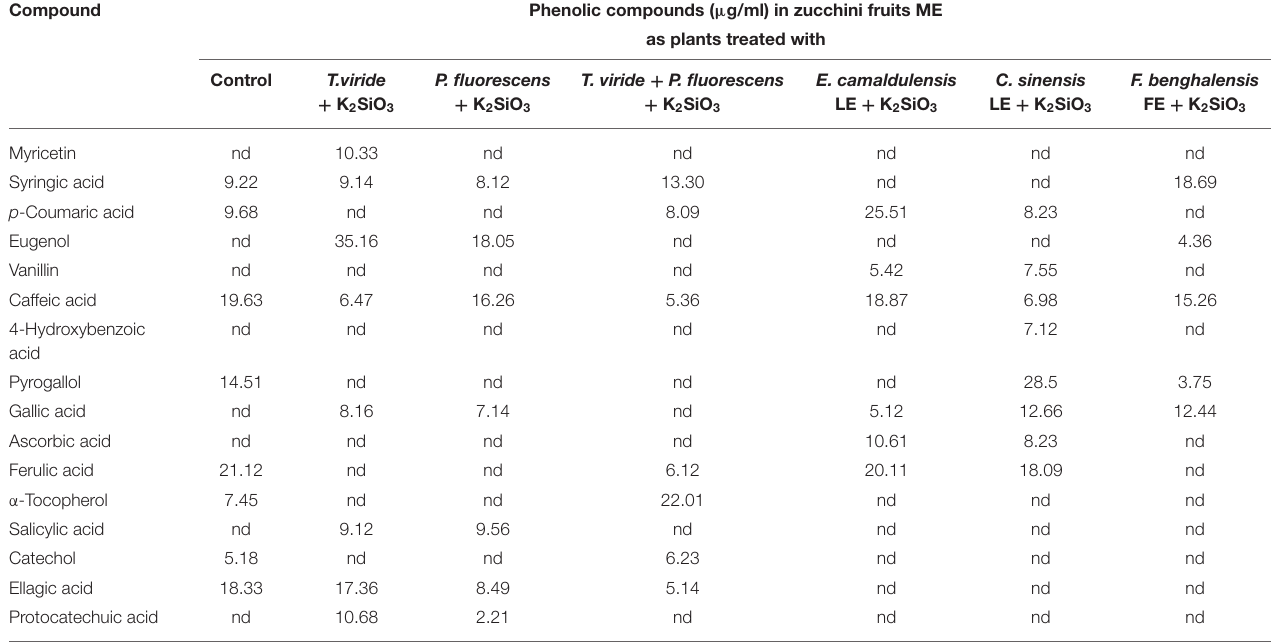
TABLE 4 | Effect of plant extracts, microbial inoculations, and potassium silicate biostimulants on phenolic compounds identified in zucchini fruits methanol extract in the second experiment.